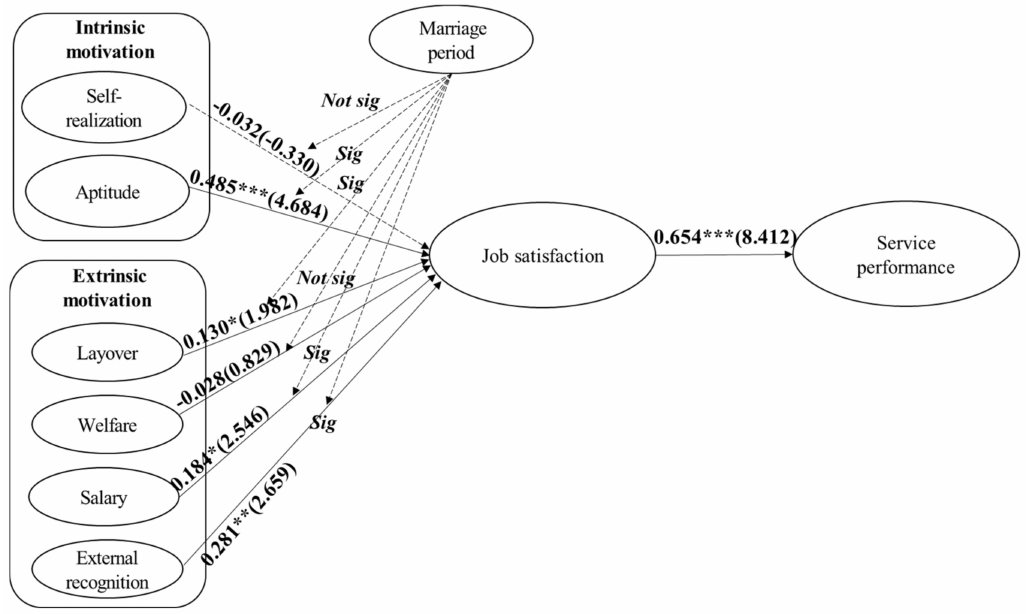
Figure 3. Results of research model (*** p < 0.001, ** p < 0.01, * p < 0.05).